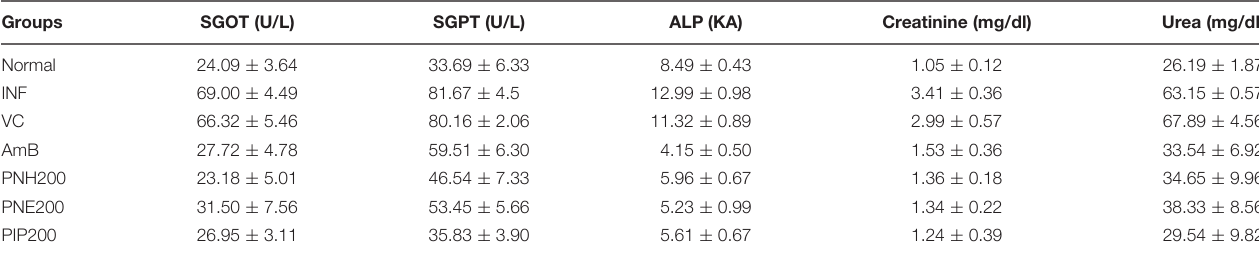
TABLE 2 | Estimation of serum levels of liver enzymes and kidney